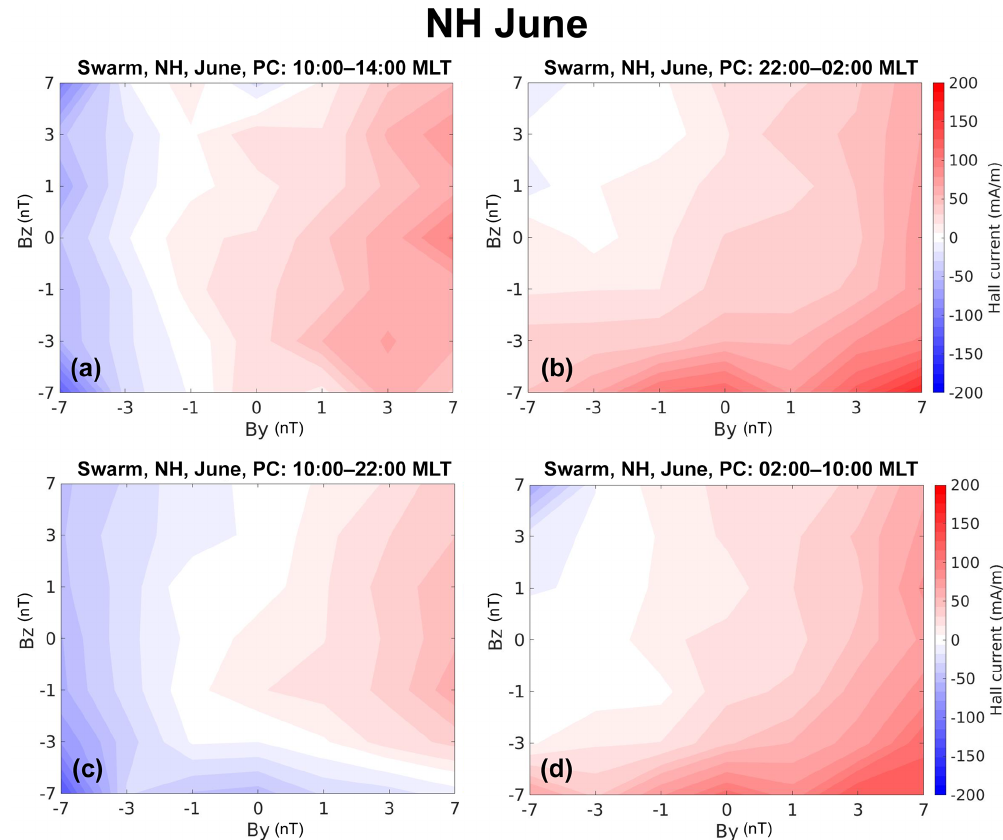
Figure 8. IMF dependence of polar cap Hall current flow direction in the Northern Hemisphere during June solstice (local summer). Eastward (westward) currents are shown in red